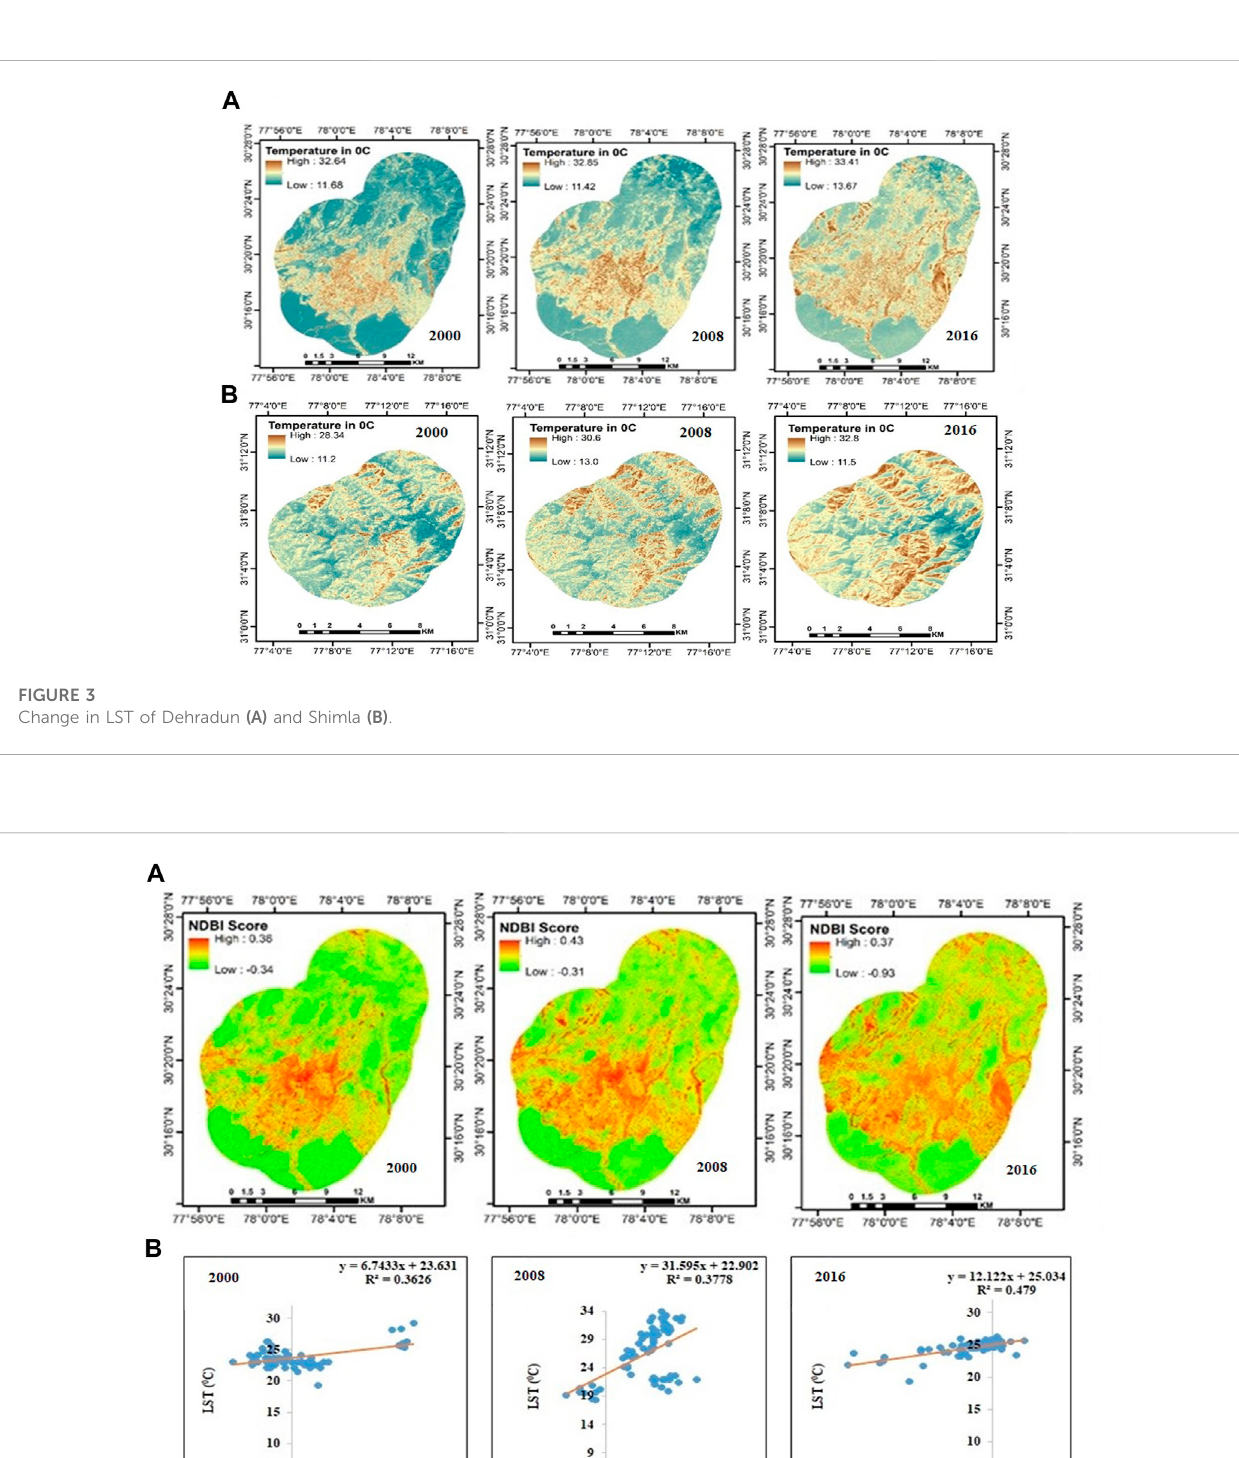
Frontiers in Environmental